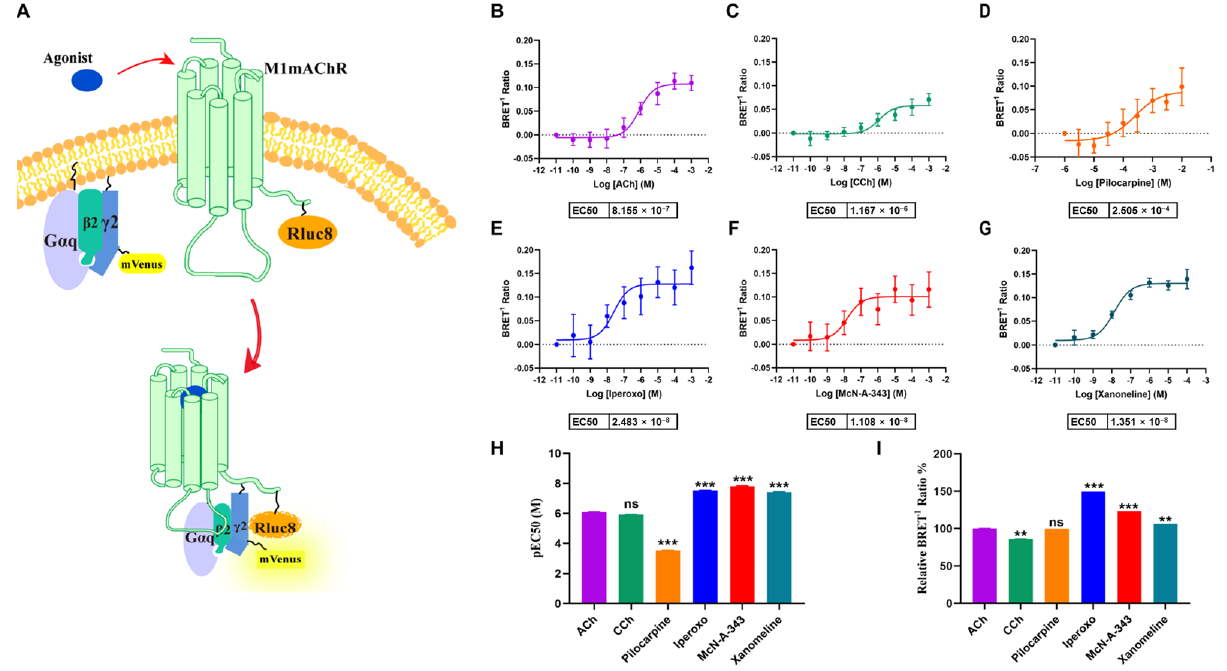
Figure 2. Efficacy of agonists in G α q-binding to M1mAChR revealed by BRET assays. ( A ) Schematic illustration of bioluminescent resonance energy transfer (BRET) and dose-response curves for ACh- ( B ), CCh- ( C ), Pilocarpine- ( D ), Iperoxo- ( E ), McN-A-343- ( F ), and Xanomeline-induced ( G ) G α q interactions with M1mAChR. ( H ) EC50 of agonists and ( I ) Emax of agonists (means ± S.E.M., n = 3). The statistical signi fi cance of the di ff erences between the indicated groups and the ACh was as- sessed by one-way ANOVA, where *** p < 0.001, ** p < 0.01 is ns, not signi fi cant.